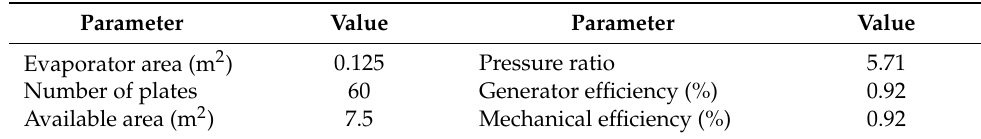
Table 6. Design parameters for the ORC.